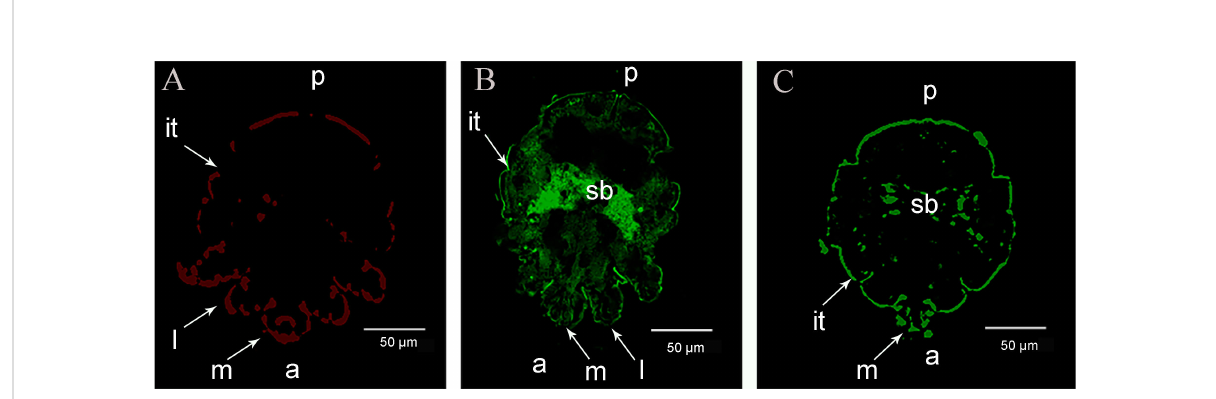
FIGURE 4 Immunolocalization of the SsAKs in S. scabiei . (A) Incubation with rat negative serum as the primary antibody. (B) Incubation with rat anti-rSsAK- 1 IgG as the primary antibody. (C) . Incubation with rat anti-rSsAK-2 IgG as the primary antibody. a, front end; p, rear end; m, mouthparts; l, legs; it, integument of the exoskeleton; sb, stomach and intestine.